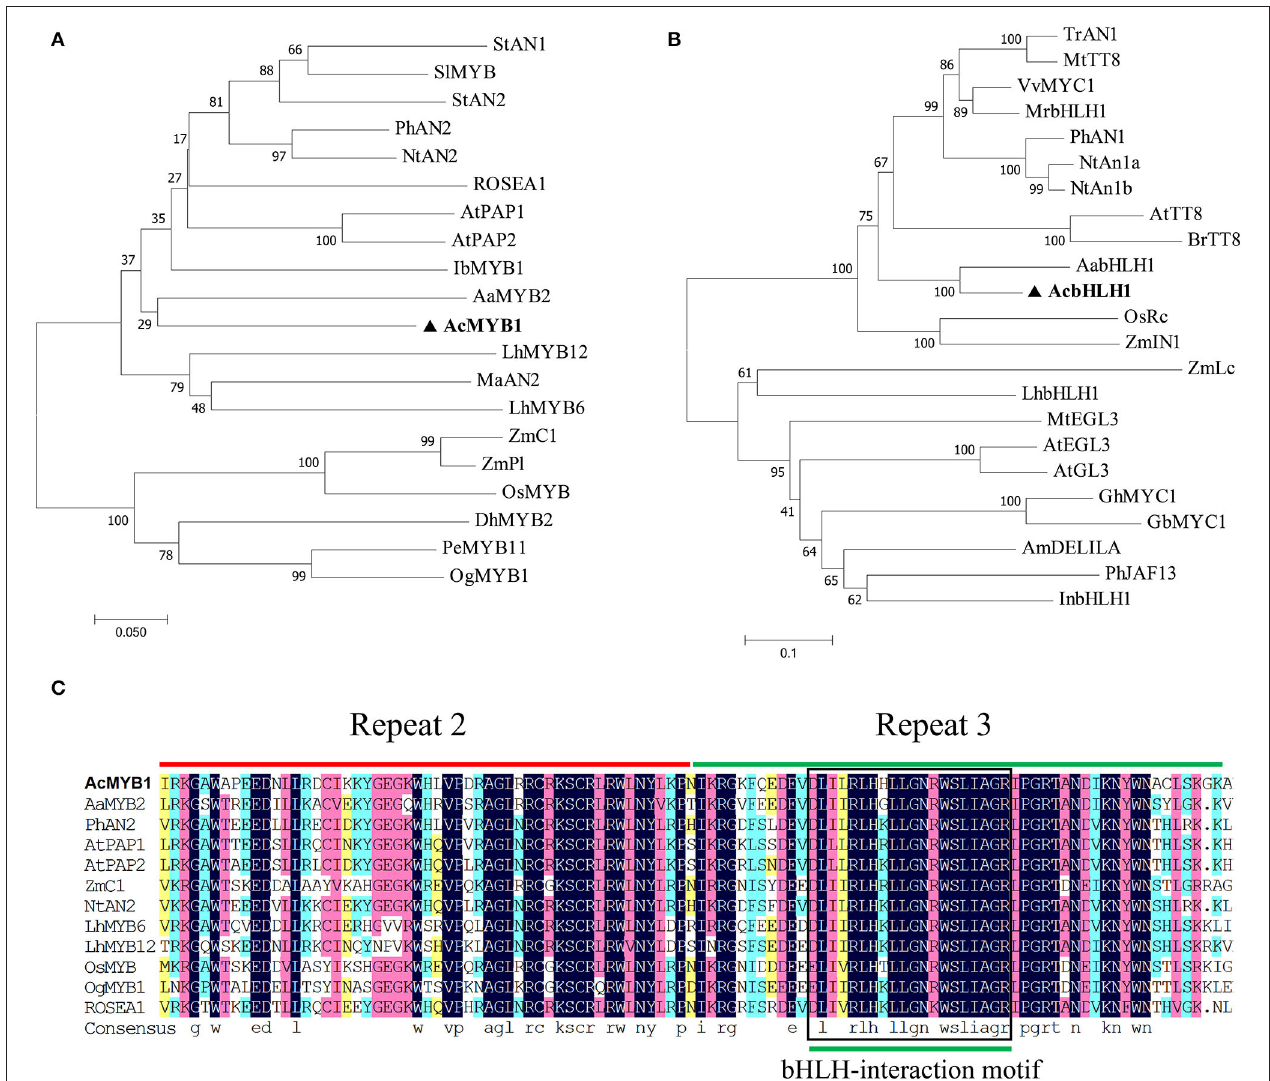
FIGURE 2 | Phylogenic and sequence alignment analyses of A. commutatum “Red Valentine” AcMYB1 and AcbHLH1. Phylogenetic relationships of (A) AcMYB1 and (B) AcbHLH1 with known anthocyanin MYB and bHLH transcription factors, respectively, from monocotyledon and other species. The neighbor-joining method with 1,000 bootstrap replications was performed using MEGA (v7.0.26). (C) Amino acid sequence alignments of the R2 and R3 domains in AcMYB with the functionally characterized R2R3-MYBs regulator using DNAMAN (v8.0.8.789). The R2 and R3 domains are shown with red and green lines, respectively, and the bHLH-interacting motif is indicated in the black box. bHLH; basic helix–loop–helix, MYB: myeloblast. The GenBank accession numbers of the MYB and bHLH proteins are listed in Supplementary Table S1